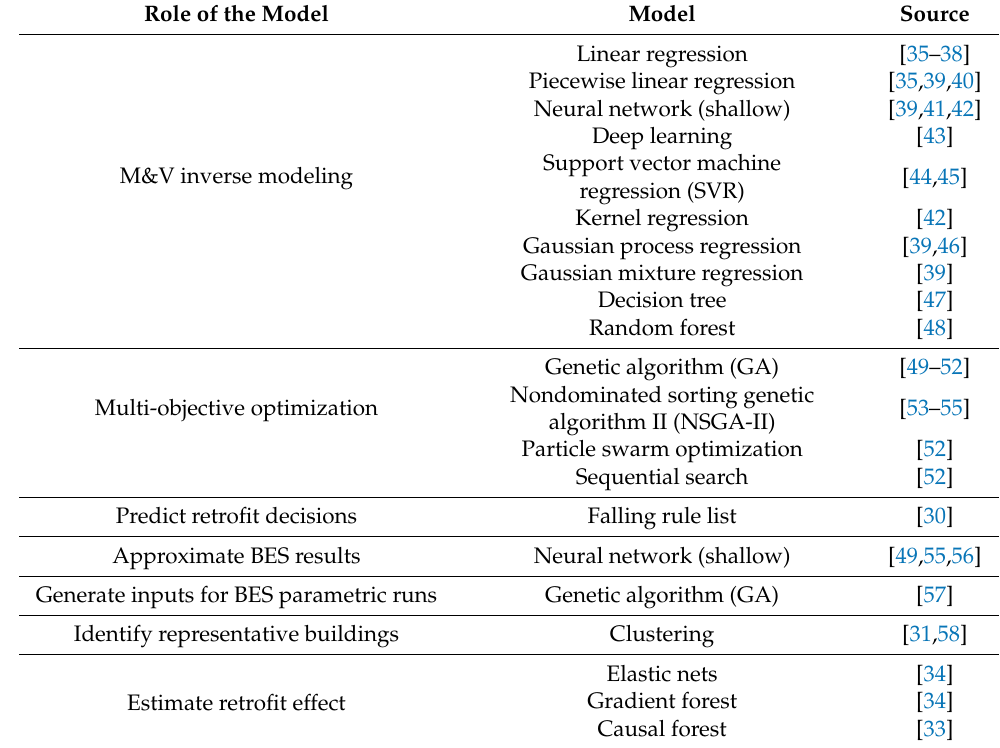
Table 2. Data-driven methods used in retrofit evaluation or